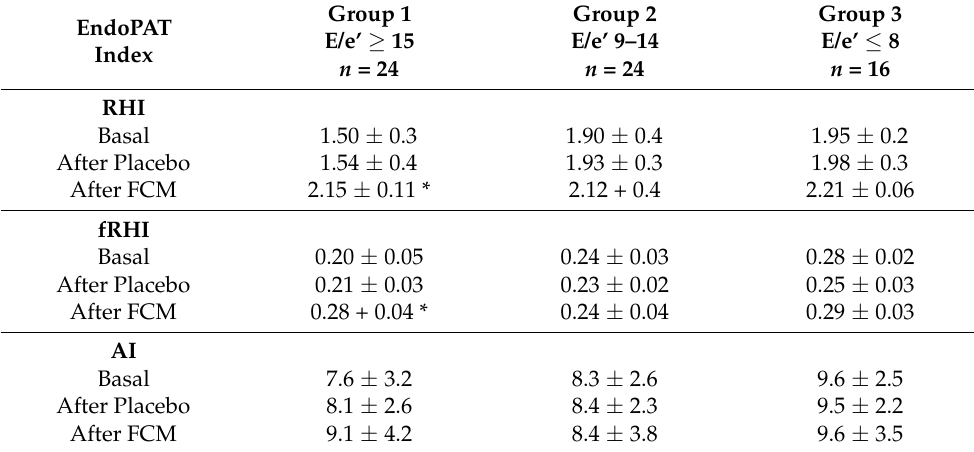
Table 4. Parameters of endothelial functionality measured via EndoPAT methodology (see methods) at time 0 (basal) and after 8 weeks from starting the treatment with FCM or the placebo in patients with HFpEF classified according to the E/e’ ratio (Groups 1, 2, and 3). Data are expressed as mean ±